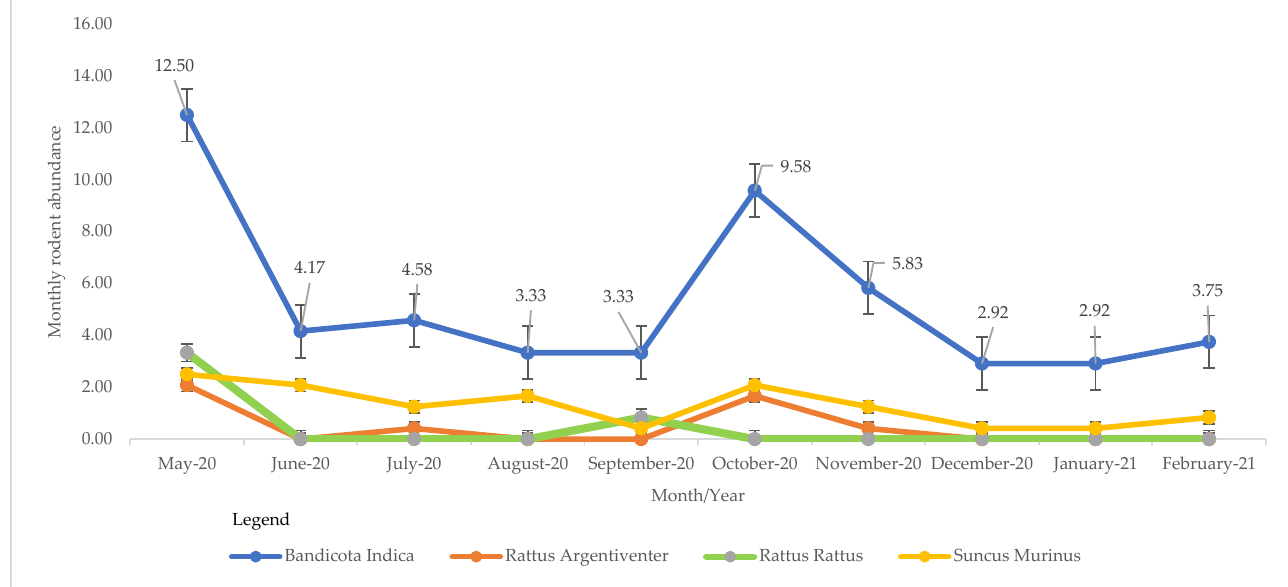
Figure 2. Rodent species and abundance throughout the dry (May – September) and wet rice planting season (October – February) in Jitra, Kedah. Protein-based bait was used in trapping.